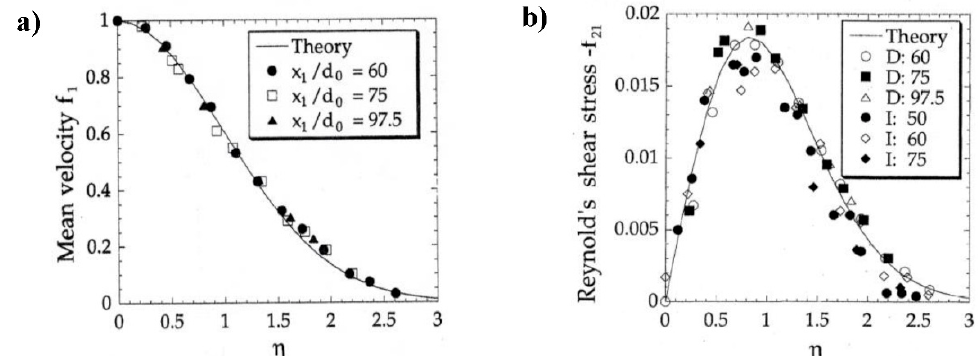
Figure 4. ( a ) Theoretical solid line curve calculated with the DQTM and experimental data symbols from Reference [31] of the average axial (downstream) velocity in the radial direction for different downstream locations. The measured points lie close to the Gaussian function. ( b ) Reynolds shear stress with two types of experimental results D (Direct) and I (Indirect) (see main text). Just as in ( a ), also in this case the agreement between theory and experiments is excellent. Reprinted with permission from Egolf and Weiss (1998) © 2021, American Physical